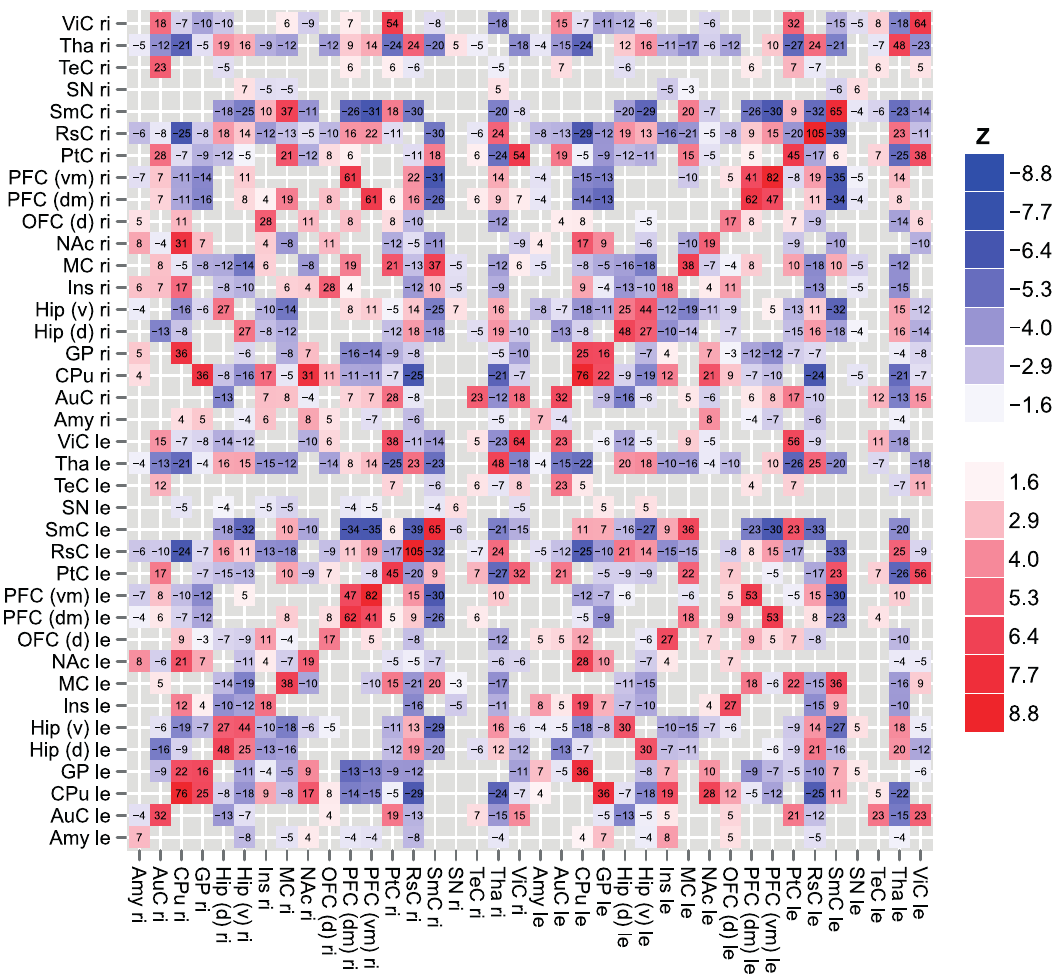
Figure 1. Seed-based resting-state fMRI functional connectivity matrices. Resting-state fMRI-based functional connectivity values were calculated and tested for significance ( p , 0.05, one-sample t -test) across all 5-HTT + / + and 5-HTT -/- animals, among all seed regions in left (le) and right (ri) hemispheres. Significant non-zero functional connectivity values were scaled by 10 2 and color-coded according to Z , the normalized t -value. The p -values were false discovery rate (FDR) adjusted for multiple comparisons. Amy : basal amygdaloid nuclei; AuC : auditory cortex; CPu : caudate- putamen; GP : globus pallidus; Hip (d) : dorsal hippocampus; Hip (v) : ventral hippocampus; Ins : insula; MC : motor cortex; NAc : nucleus accumbens; OFC (d) : dorsal orbitofrontal cortex; PFC (dm) : dorsomedial prefrontal cortex; PFC (vm) : ventromedial prefrontal cortex; PtC : parietal cortex; RsC : retrosplenial cortex; SmC : somatosensory cortex; SN : substantia nigra; TeC : temporal cortex; Tha : thalamic nuclei; ViC : visual cortex.